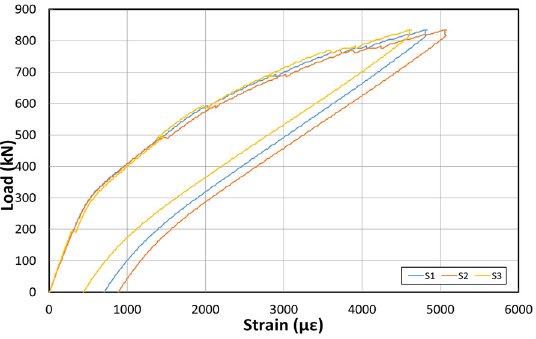
Figure 17. Inner tendon strain curve at the bottom after reinforcement based on the EP method.